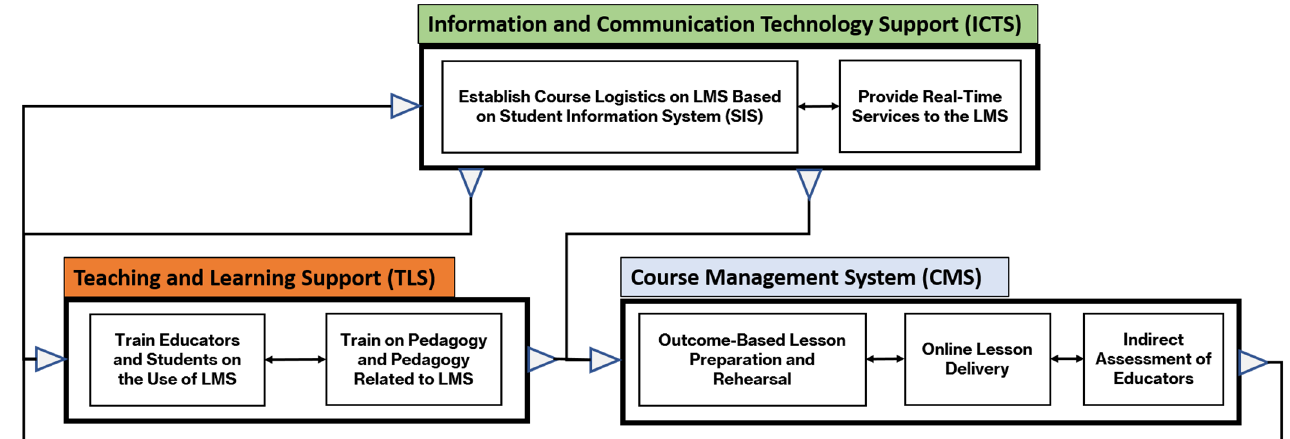
Figure 1. Quality Assurance (QA) framework for the design and delivery of virtual and real-time courses.